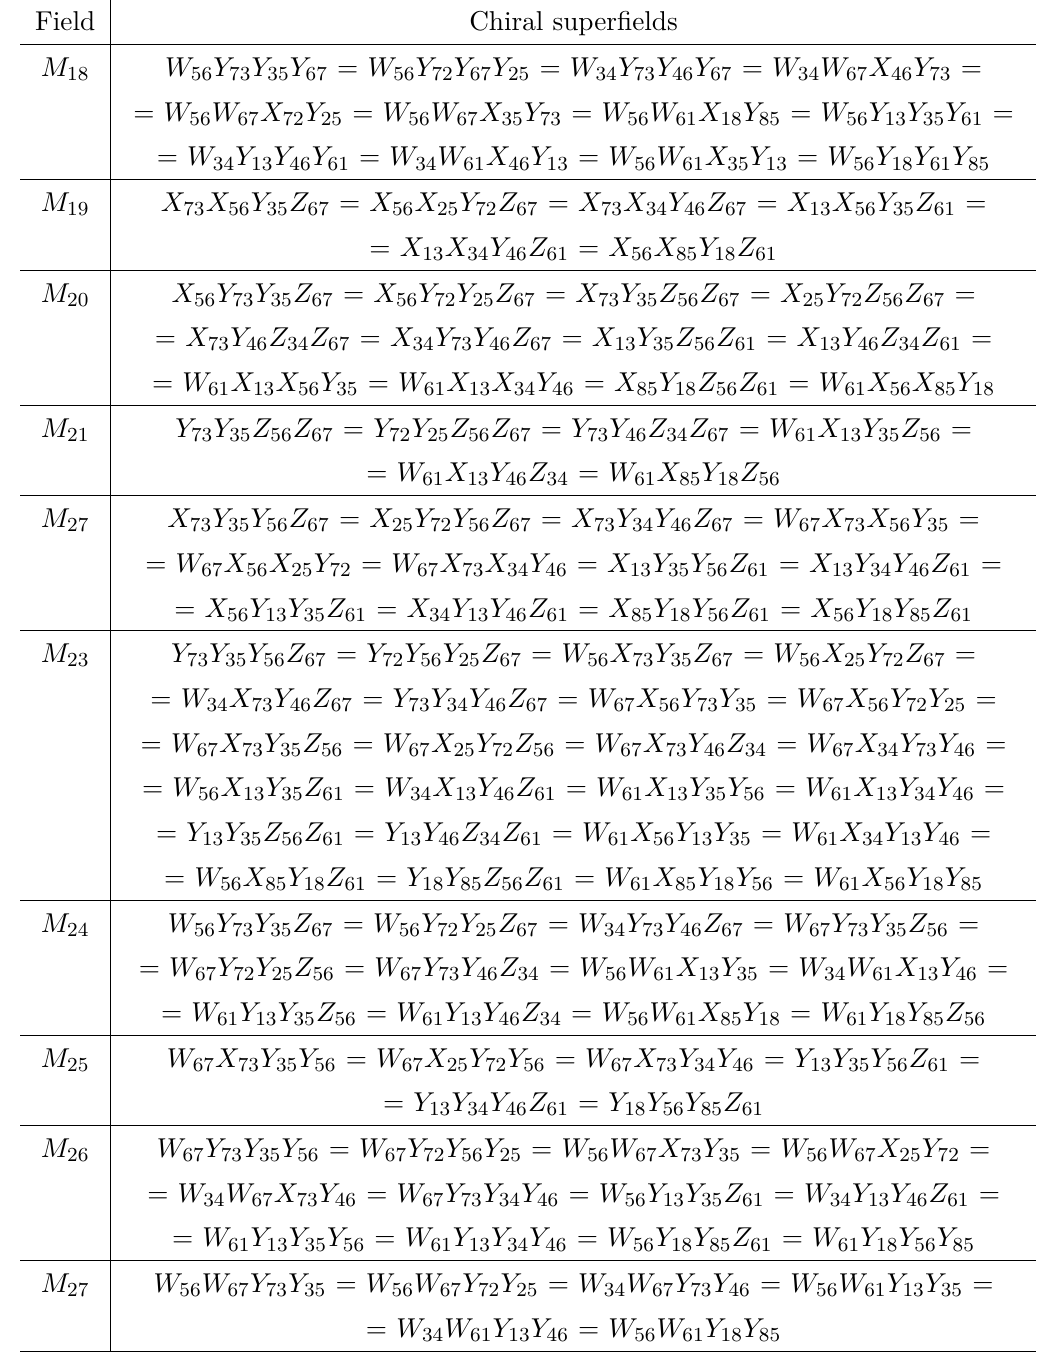
Table 10. Generators of Q 1 , 1 , 1 / Z 2 in Phase